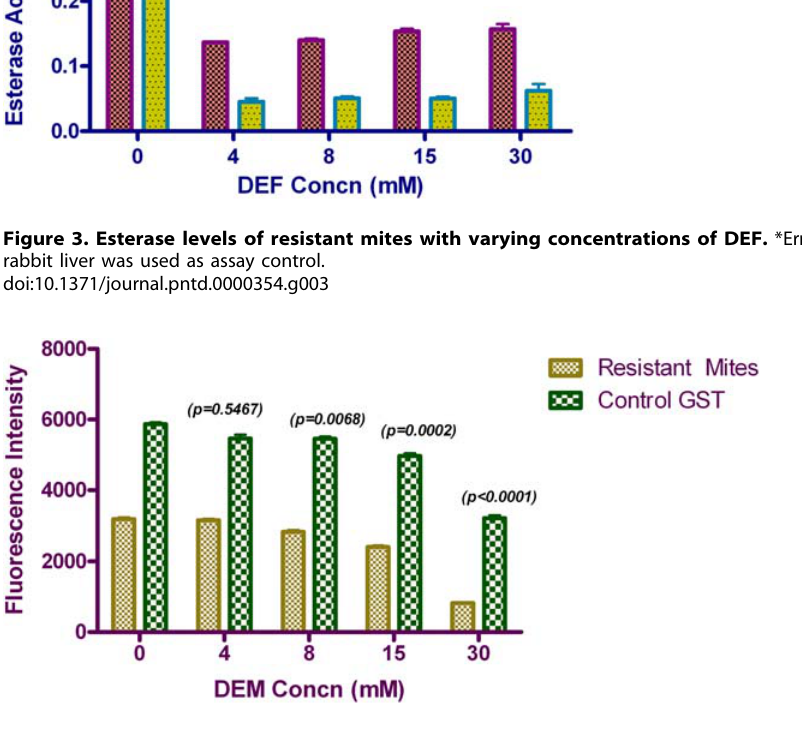
Figure 4. GST levels of resistant mites with varying concentrations of DEM. *Error bars represent SEM. **Commercial GST from equine liver was used as assay control.